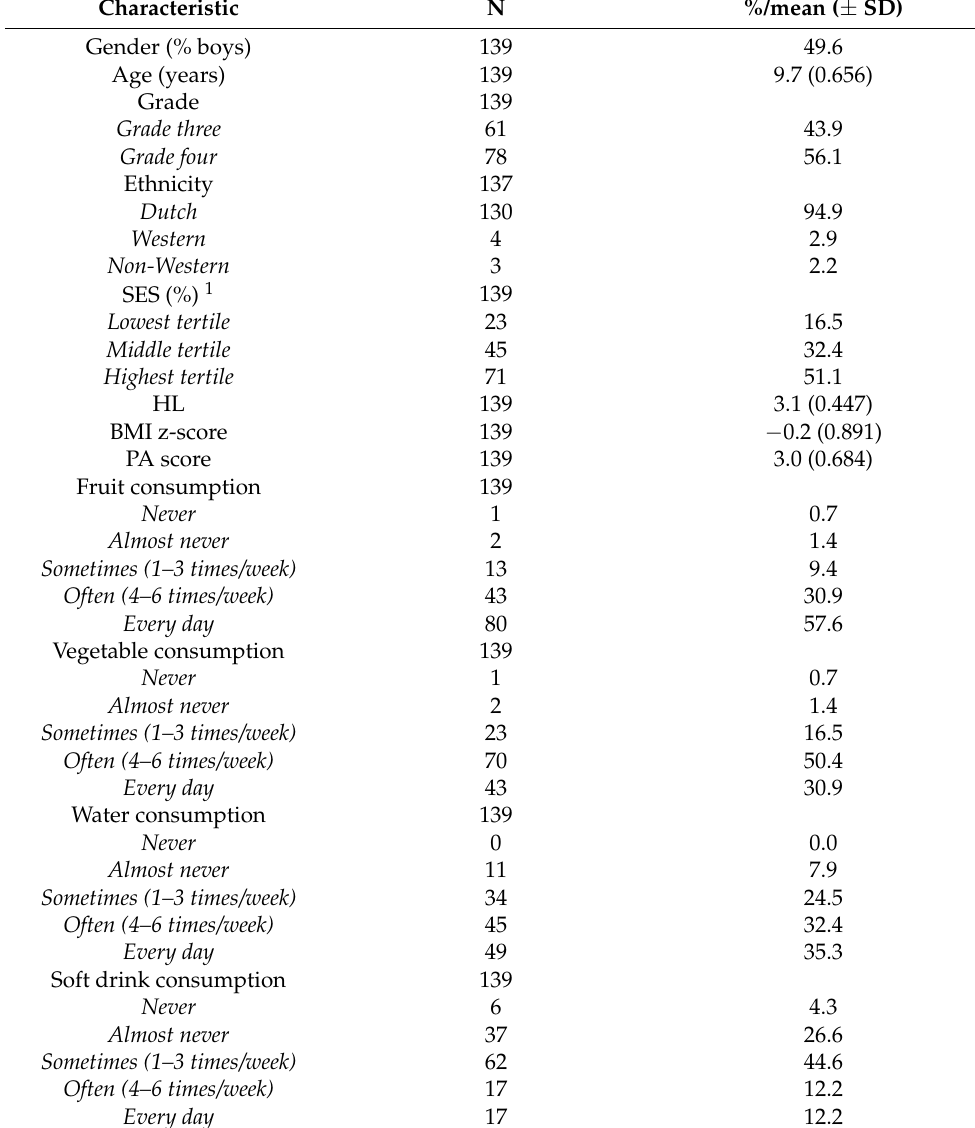
Table 1. Sample characteristics ( n = 139).